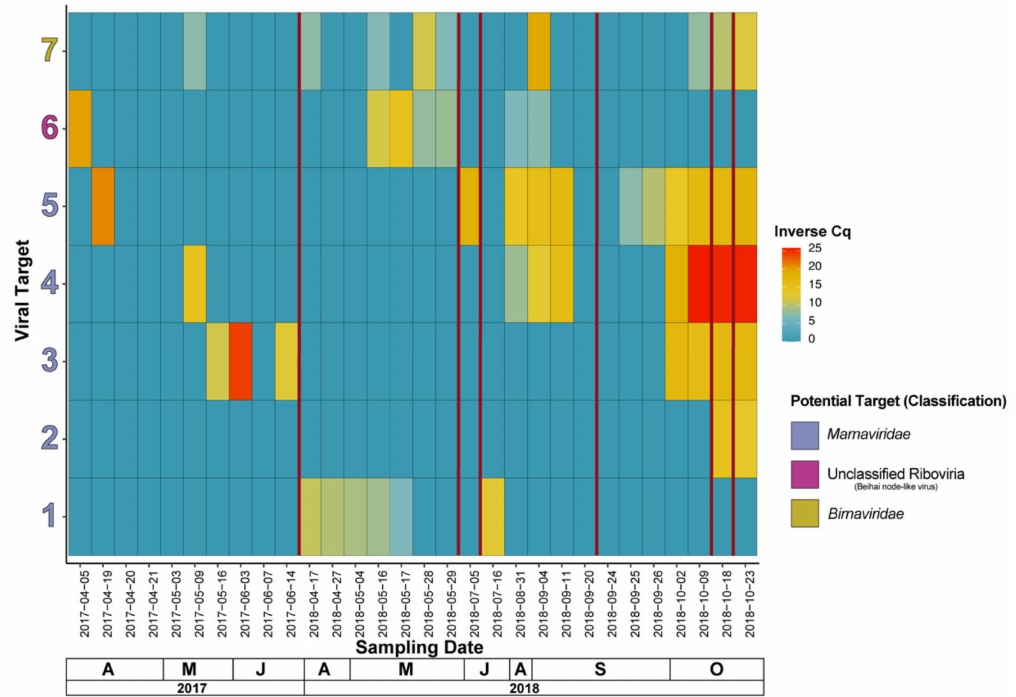
Figure 6. Occurrence and relative intra-species (i.e., viral population) abundance over a time series of 2017 and 2018 sampling dates, including metagenomic samples, using an RT-qPCR assay. An inverse of the quantitation cycle (Cq) is represented (45 cycles minus the Cq value), where a higher value indicates a higher relative abundance. The period between two samples where a microalgal culture die-off occurred in the basin are represented by vertical red lines (5 in total). Further information on RNA viral targets (1–7) is included in Table